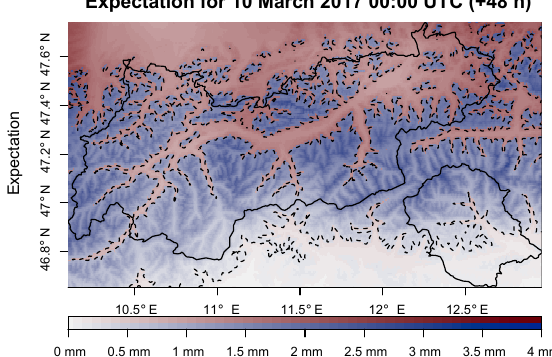
Figure 11. Expected 1h amount of liquid water content for 10 March 2017 00:00UTC ( + 48h forecast initialized 8 March 2017). Areas with a higher chance of observing snow are shown in blue, those with a higher chance of observing rain in red. The dashed line (top) shows the forecasted snow line with an equal chance of observing snow or rain (Eq. 12). Overlay: governmental area of Tyrol (solid